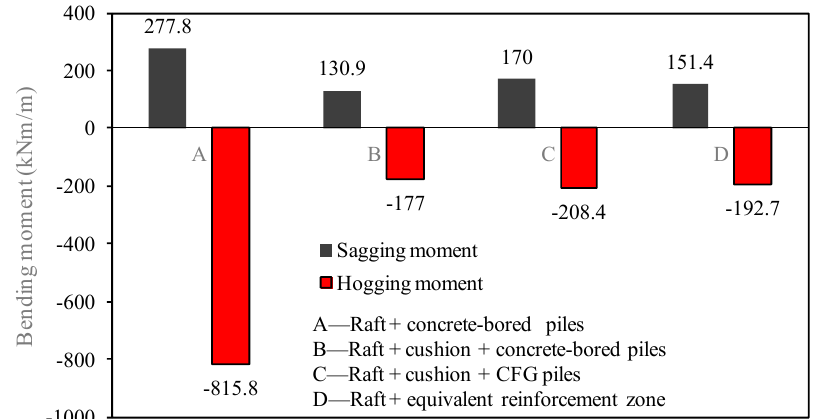
Figure 12. Comparison of extrema of the bending moments of the raft under the four simulated schemes.